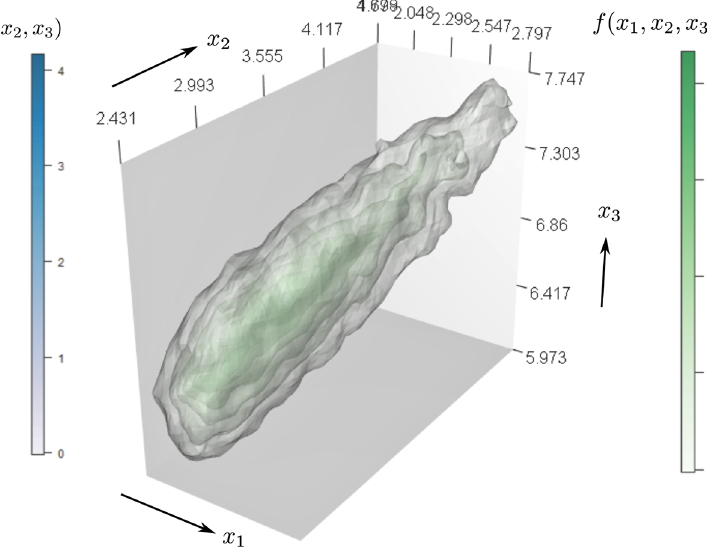
Fig. 2. Volumetric isosurfaces density visualization of the approximate GUM supplement 2 Gaussian joint PDF obtained from synthetic Monte Carlo data sampled from a Gaussian dis- tribution using second order statistical moments based expected value and covariance information.